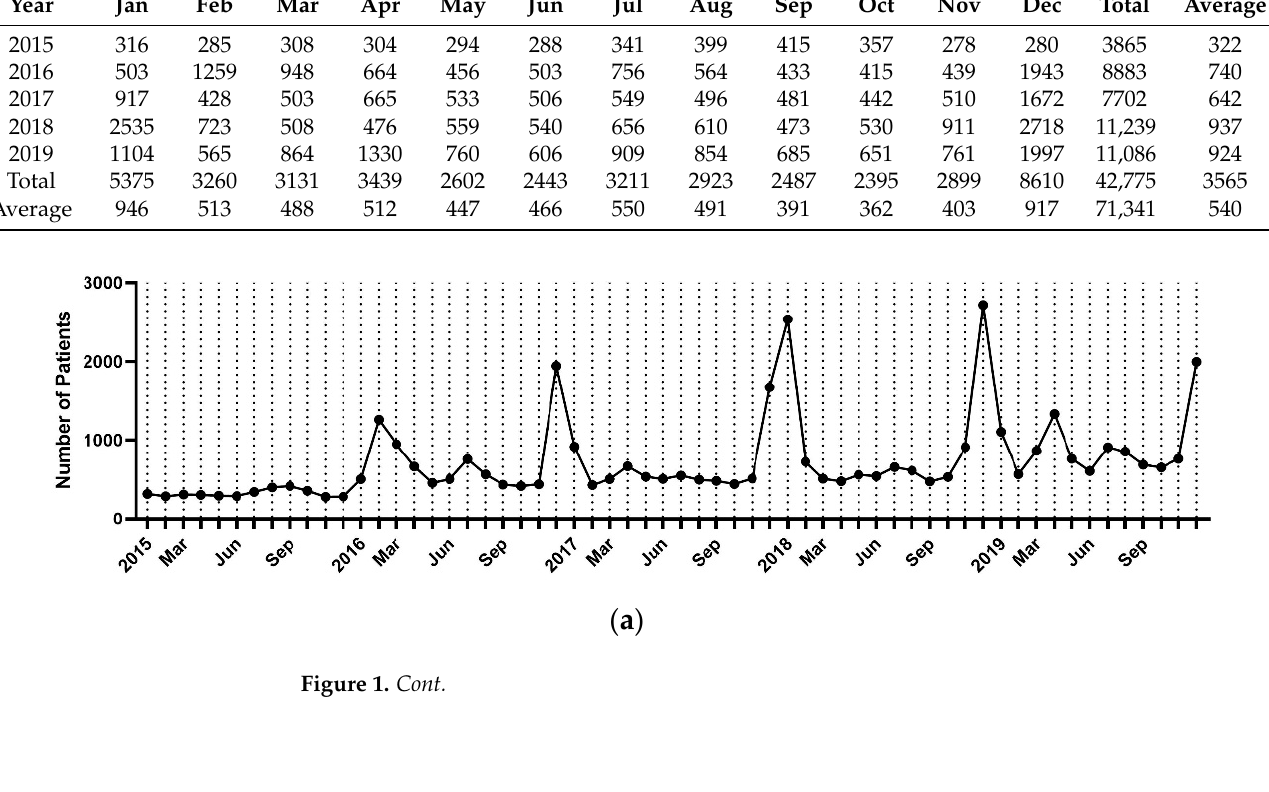
Table 3. Monthly numbers of newly diagnosed encephalitis patients in Korea.